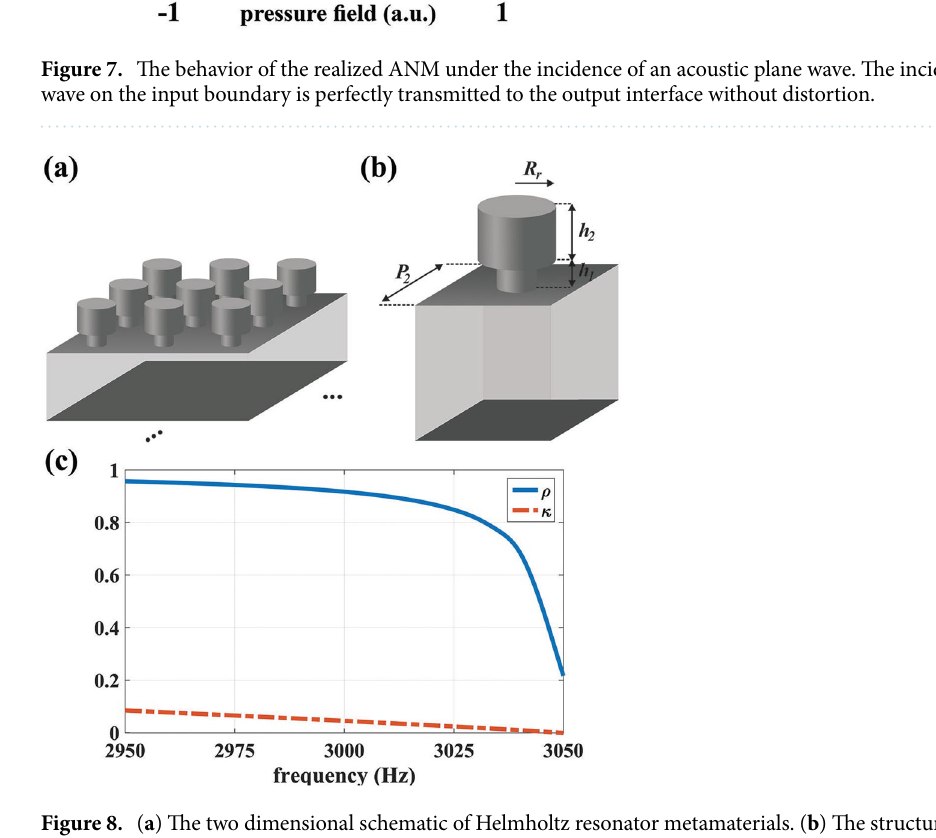
4 mm, h 1 1 mm, h 2 6.38 mm and = = =